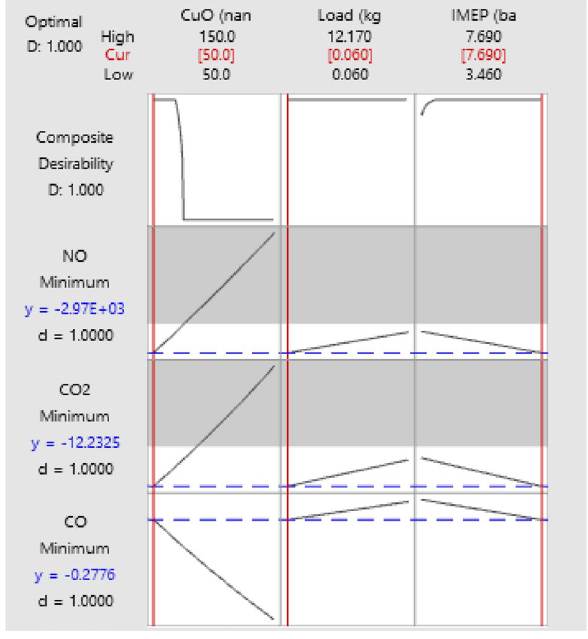
Fig. 37 Optimization of process parameters with